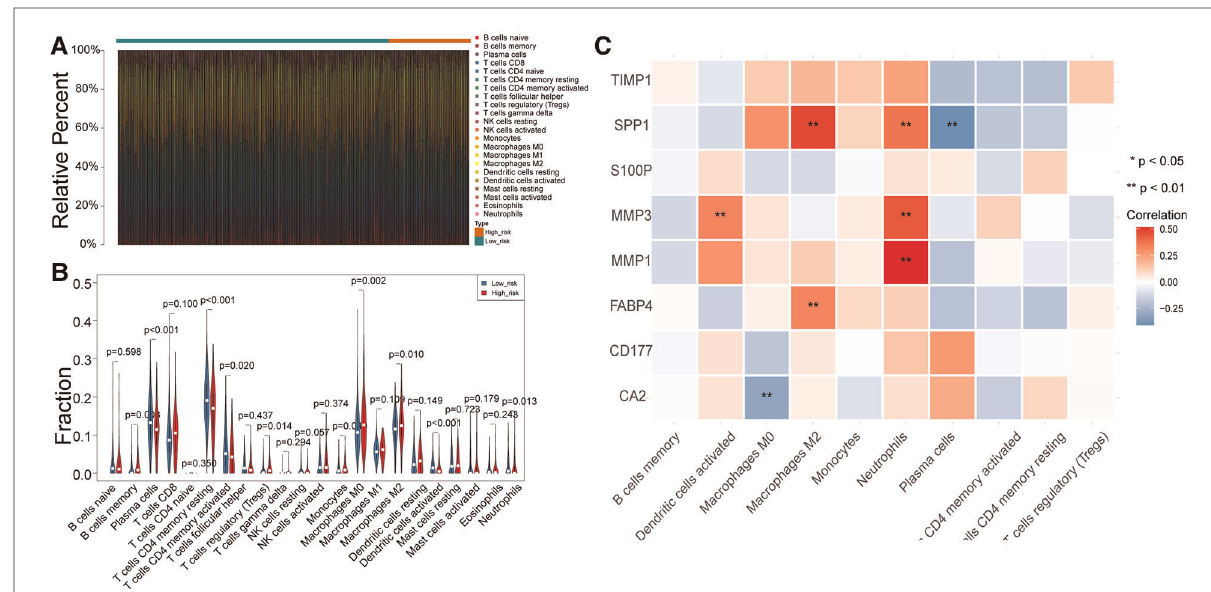
FIGURE 7 Differences in immune in fi ltrating cells between the high- and low-risk patients with CRC. ( A ) Rrelative percent of immune in fi ltrating cells in each CRC sample. ( B ) Violin plot of immune in fi ltrating cells between high- and low-risk groups. ( C ) Correlation between UC-related prognostic genes and differential immune in fi ltrating